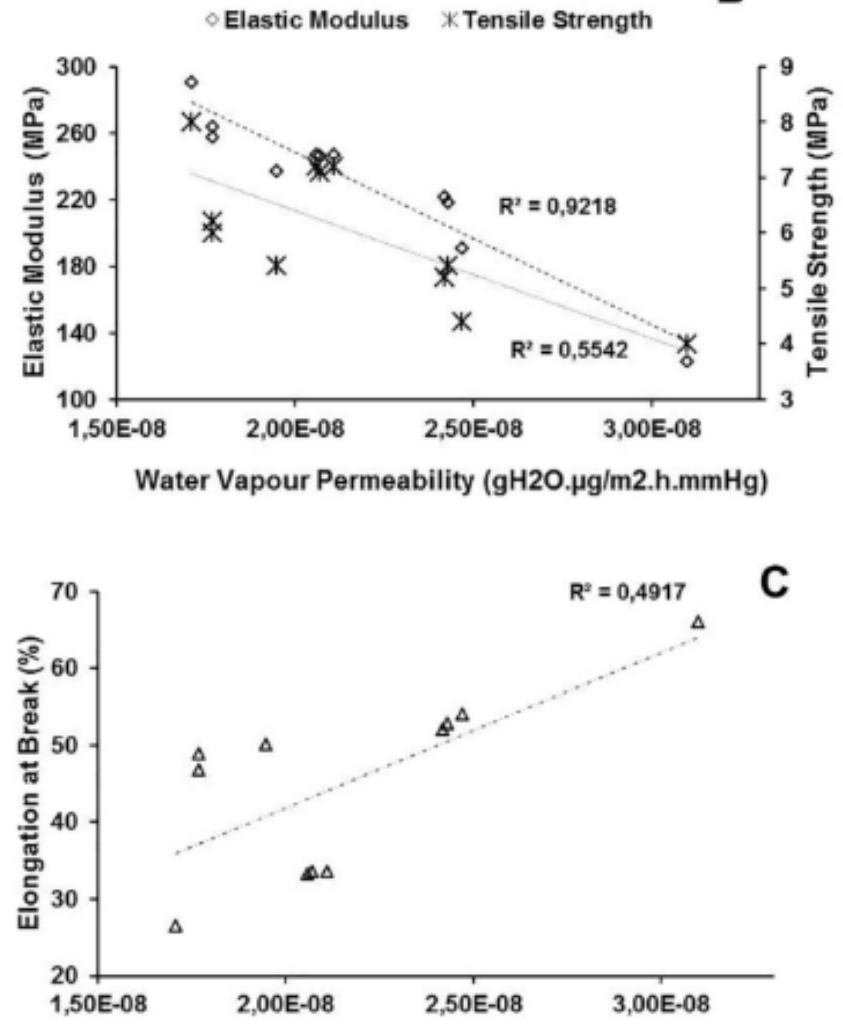
Figure 5. ( A ) Linear correlation between the CNC and the physico-chemical properties, ( B ) water vapor permeability (WVP), and, ( C ) mechanical properties of the films [103]. (Reproduced with a